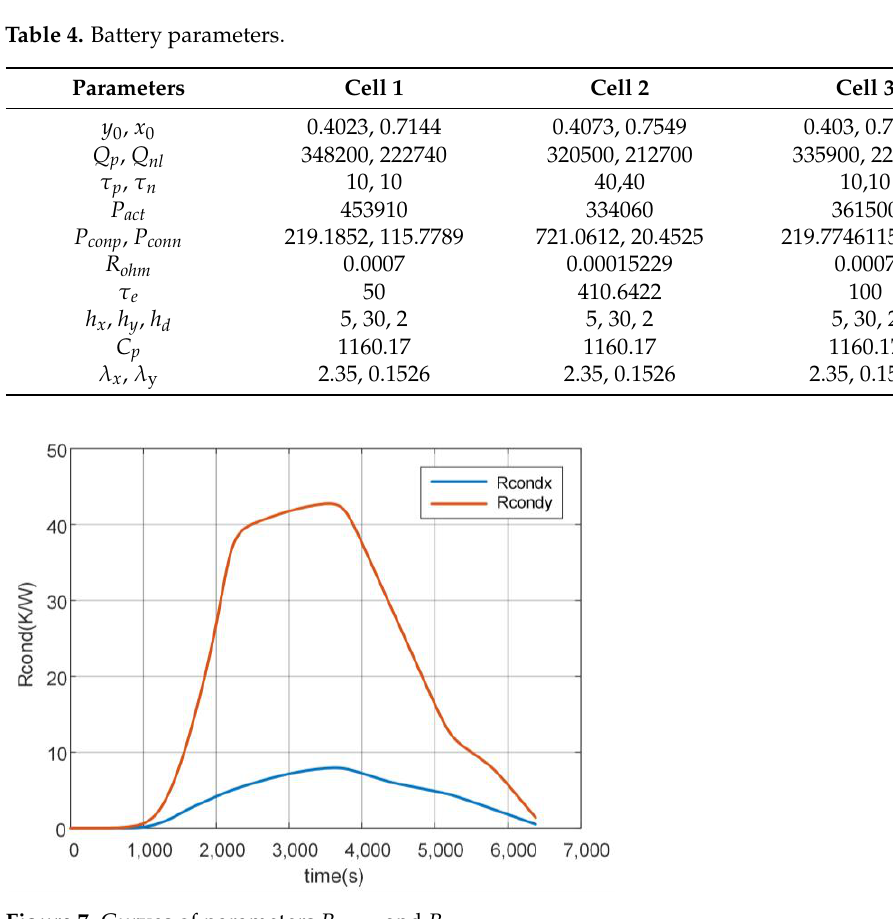
Figure 7. Curves of parameters R condx and R condy.